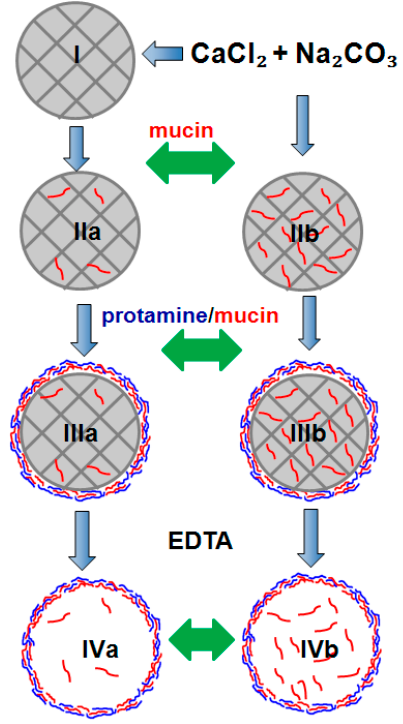
Figure 5. Schematics of formulation of microparticles (crystals and polymer capsules) using mucin: I–CaCO 3 crystals; II–the crystals with mucin loaded by adsorption ( a ) or co-synthesis ( b ); III–crystals coated with three layer of oppositely charged protamine and mucin; IV–polymer-based microcapsules obtained after dissolution of the coated crystals using EDTA. Green arrows indicate a step of introduction of a BAC to be further encapsulated into the microparticles.